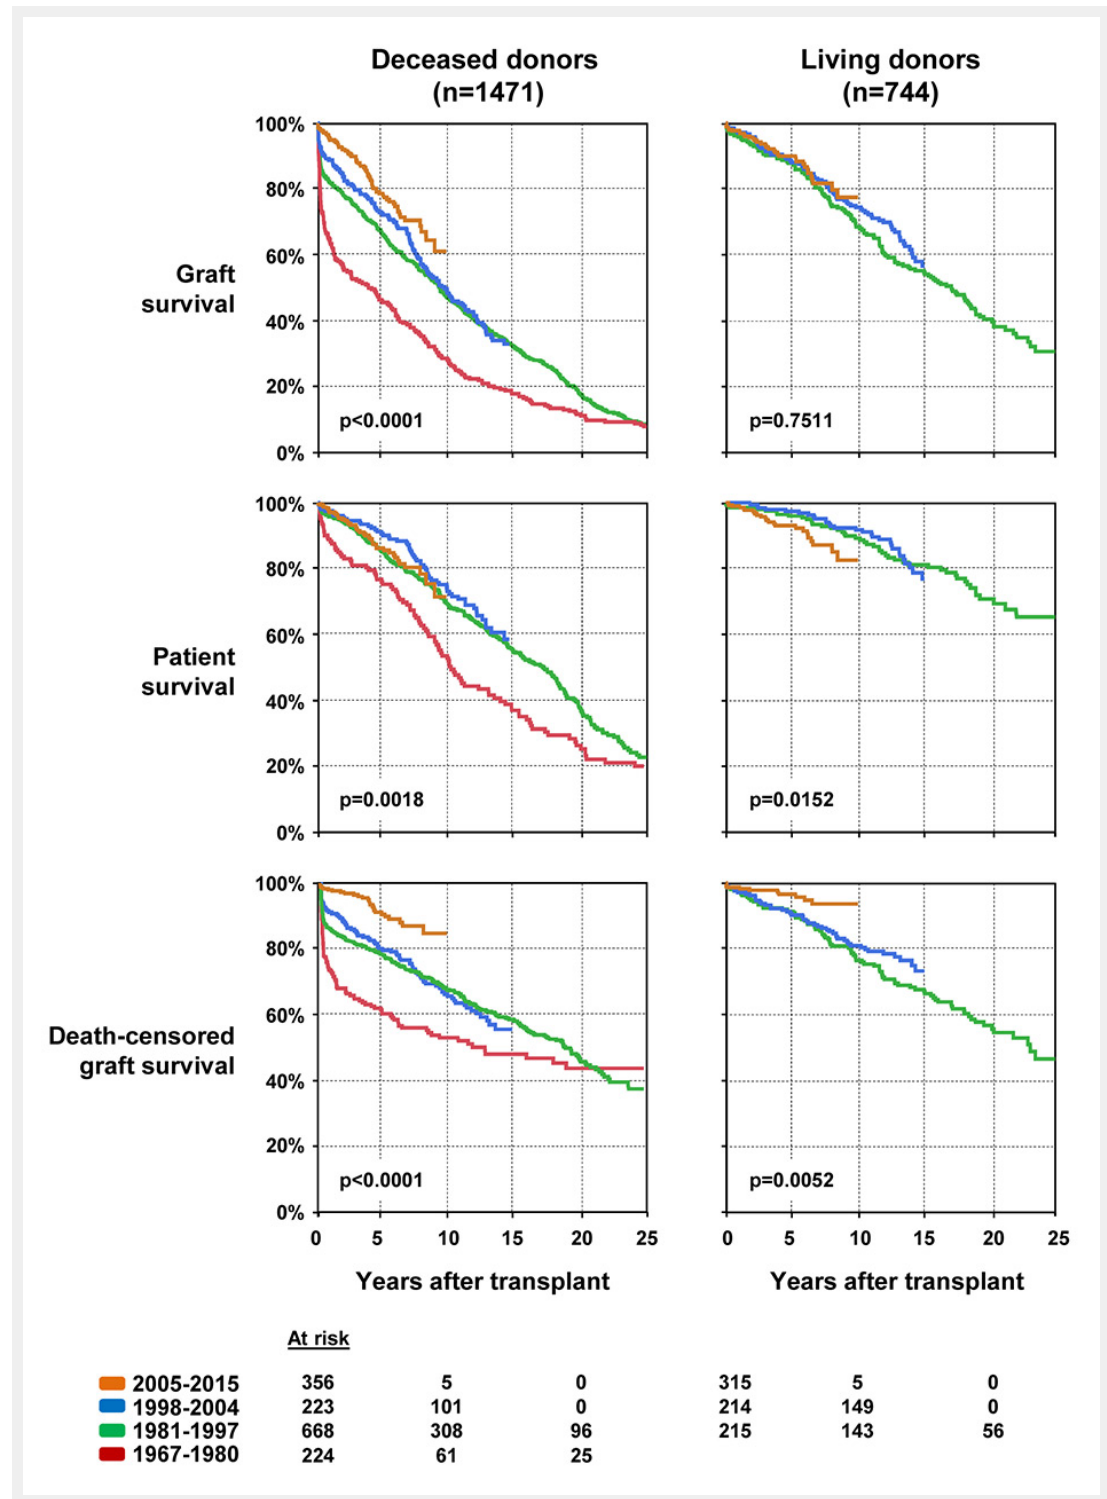
Figure 5 Evolution of graft survival, patient survival and death-censored graft survival, grouped by the donor source (living vs deceased). Due to the limited number of living donor transplantations in the era from 1967 to 1980 (n = 7), the Kaplan-Meier curve for this era is not